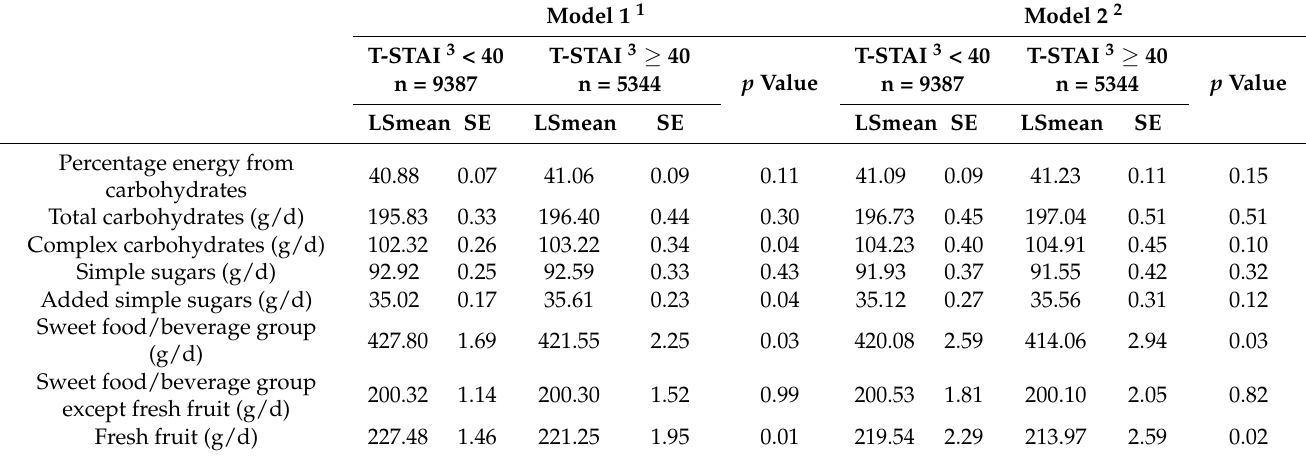
Table 3. Comparison of mean daily intake of sugar between high and low trait anxiety groups (non-diabetic adults aged ≥ 45 years; n =